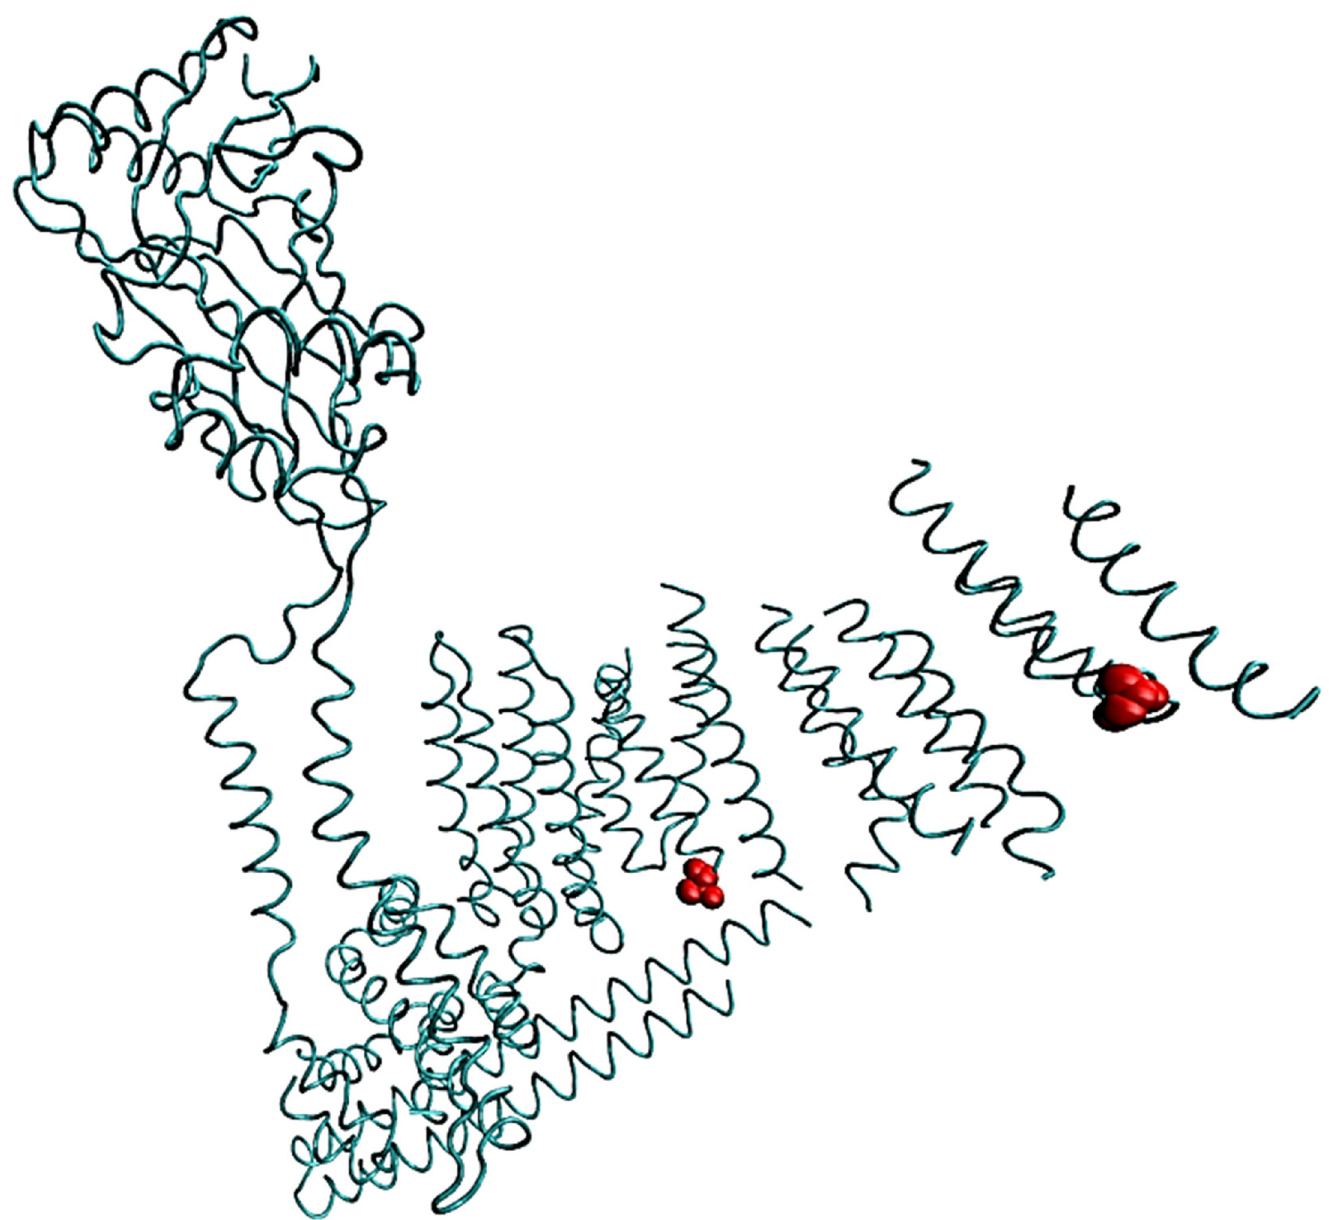
Fig 1. Approximate site where PIEZO1 is split into two protein domains based on the cryoEM structure of mouse Piezo1. The amino acid 1591 is in a region that is disordered. Residues in red are positions 1514 and 1739 (mouse numbering) that border the disordered region and indicate approximately where the fluorescent protein resides. One subunit of the trimer is